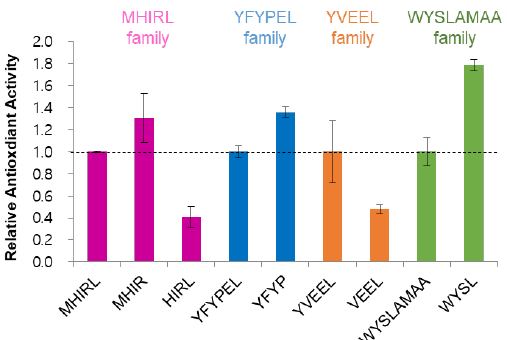
Figure 3. Relative antioxidant activities of peptides that are based on the percentage of lipid peroxidation inhibition after 24 h. The reaction was conducted at 50 °C under dark conditions. The final concentration of peptides was 250 μM. Each experiment was performed in triplicate and the values are presented as the mean ± standard error.